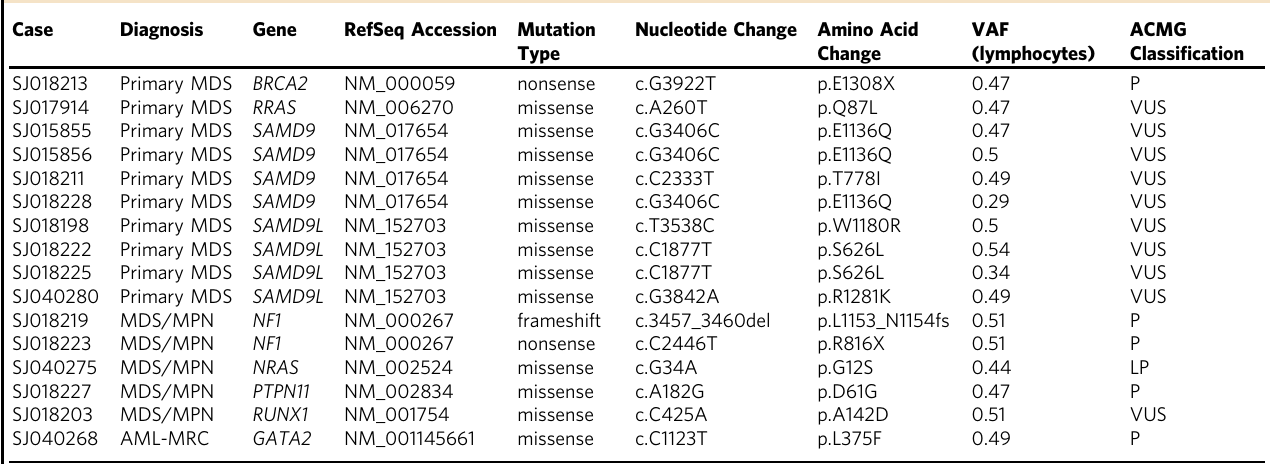
Table 2 Presumed germline mutations linked to